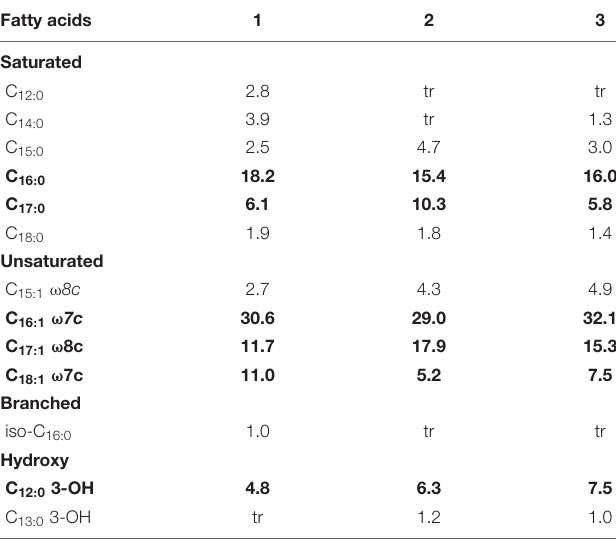
TABLE 2 | Fatty acid composition (%) of the strain 16-SW-7 and closely related strains of the genus Pseudoalteromonas. Fatty acids